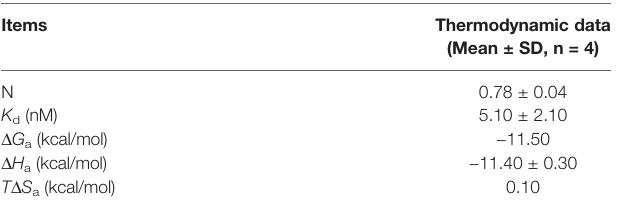
re fi nement statistics are described in Table 2 . A 1.59 Å resolution limit diffraction data was collected with a fi nal R free of 0.20 and R work of 0.18, co-crystal space group of I 222, and unit cell parameters of a = 66.18 Å, b = 89.29 Å, c = 99.56 Å; a = b = g = 90.00°. Residues Glu16 – Lys224 were observed in the re fi ned